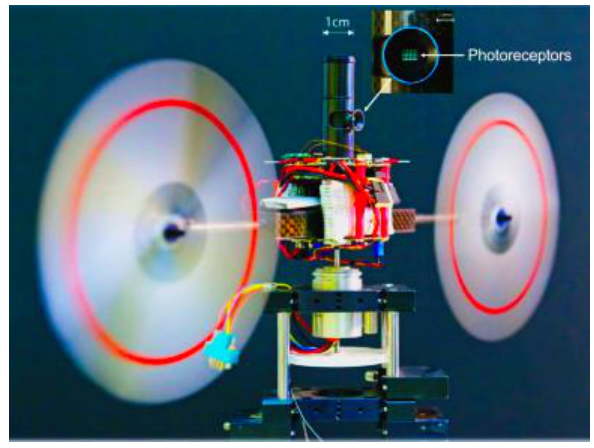
Figure 24. VODKA sensor mounted onto an MAV